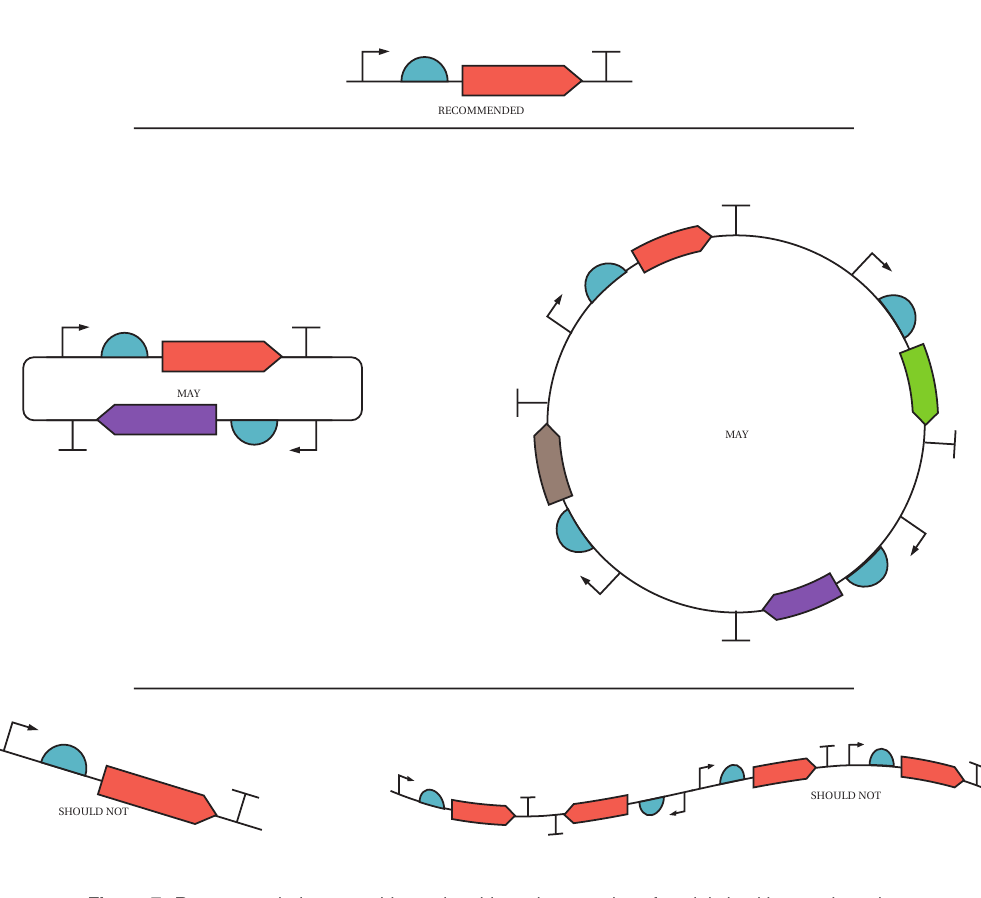
Figure 7: Recommended, acceptable, and problematic examples of nucleic backbone orientation.